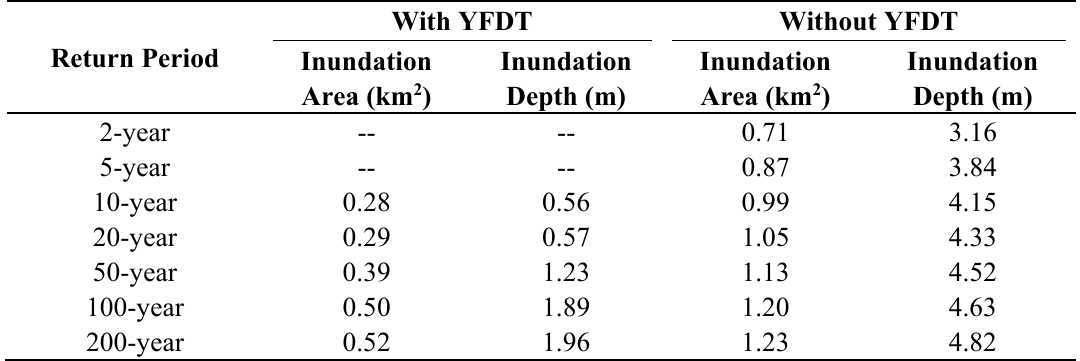
Figure 9. Comparison of the maximum inundation extent with (cyan color) and without (blue color) the Yuansantze flood diversion tunnel (YFDT) for the following return period: ( a ) 50-year; ( b ) 100-year; and ( c ) 200-year. Table 3. Maximum inundation area and inundation depth for different return periods with and without YFDT